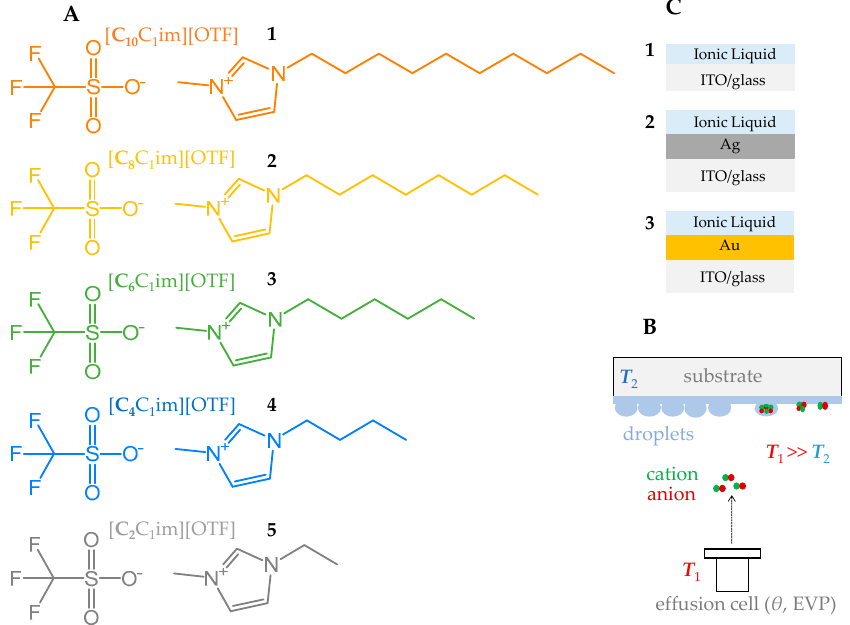
Figure 1. Molecular structure of the studied triflate-based ionic liquids and the adopted acronyms ( A ): 1-decyl-3-methylimidazolium triflate, [C 10 C 1 im][OTF]; 1-octyl-3-methylimidazolium triflate, [C 8 C 1 im][OTF]; 1-hexyl-3-methylimidazolium triflate, [C 6 C 1 im][OTF]; 1-butyl-3-methylimidazolium triflate, [C 4 C 1 im][OTF]; 1-ethyl-3-methylimidazolium triflate, [C 2 C 1 im][OTF]. Schematic representation of the effusion process ( T 1 and T 2 denote the evaporation temperature and the substrate temperature, respectively) of the ionic liquids from the Knudsen cell ( B ). Scheme of the thin-film architectures fabricated ( C ): substrate ITO/glass coated with ionic liquid (1); substrate Ag/ITO/glass coated with ionic liquid (2); substrate Au/ITO/glass coated with ionic liquid (3).